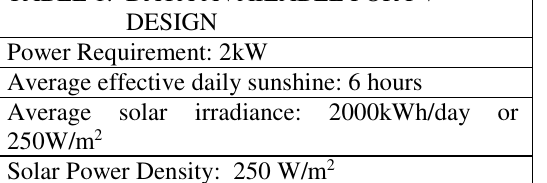
FIG. 4. ENERGY FLOW DIAGRAM TABLE 1: DATA AVAILABLE FOR PV